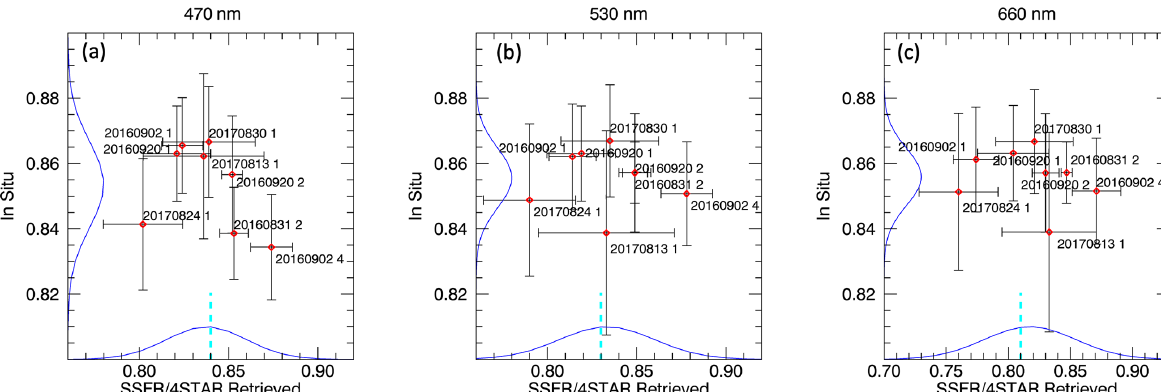
Figure 4. In situ vs. retrieved SSA values for (a) 470, (b) 530, and (c) 660nm. In situ values show transmittance-weighted SSA representative of the whole column, with error bars representing the standard deviation of all measured values throughout the spiral profile. In situ data are not available for the 20170812 case and are therefore not shown. The uncertainties for retrieved SSA for all wavelengths are provided in Appendix E. The blue dashed line indicates the values found by Davies et al. (2019).